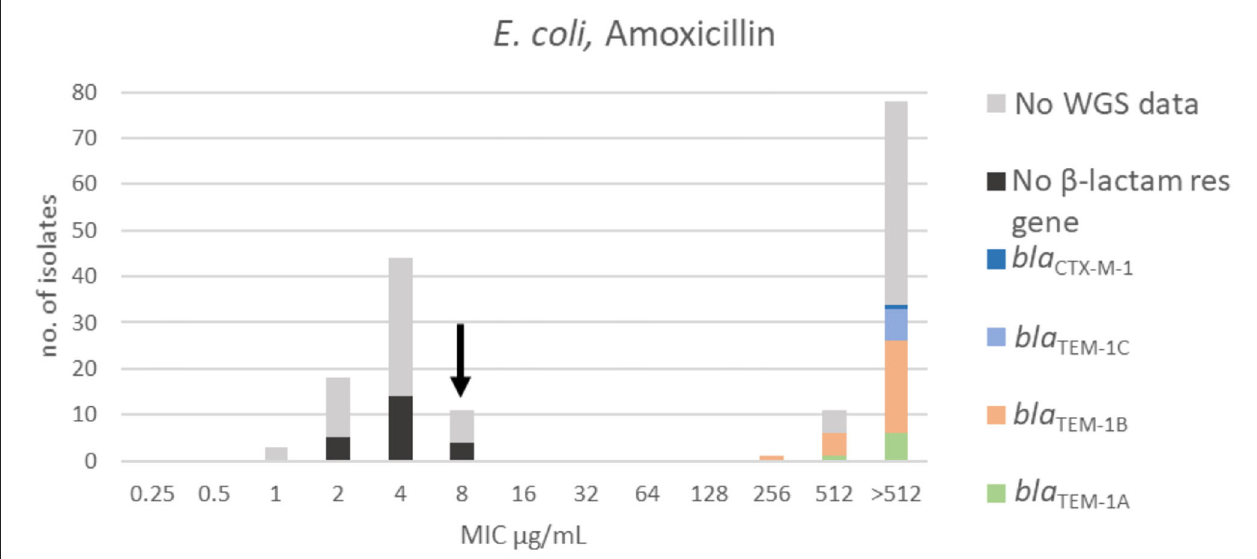
FIGURE 1 | MIC distribution of E. coli ( n = 162) against amoxicillin in the test range of 0.25–512 µ g/mL. The arrow indicates the epidemiological cut-off value (ECOFF, EUCAST). Colors indicate if the isolates have been sequenced and whether they harbor known relevant resistance genes. WGS, whole-genome sequencing; res, resistance.